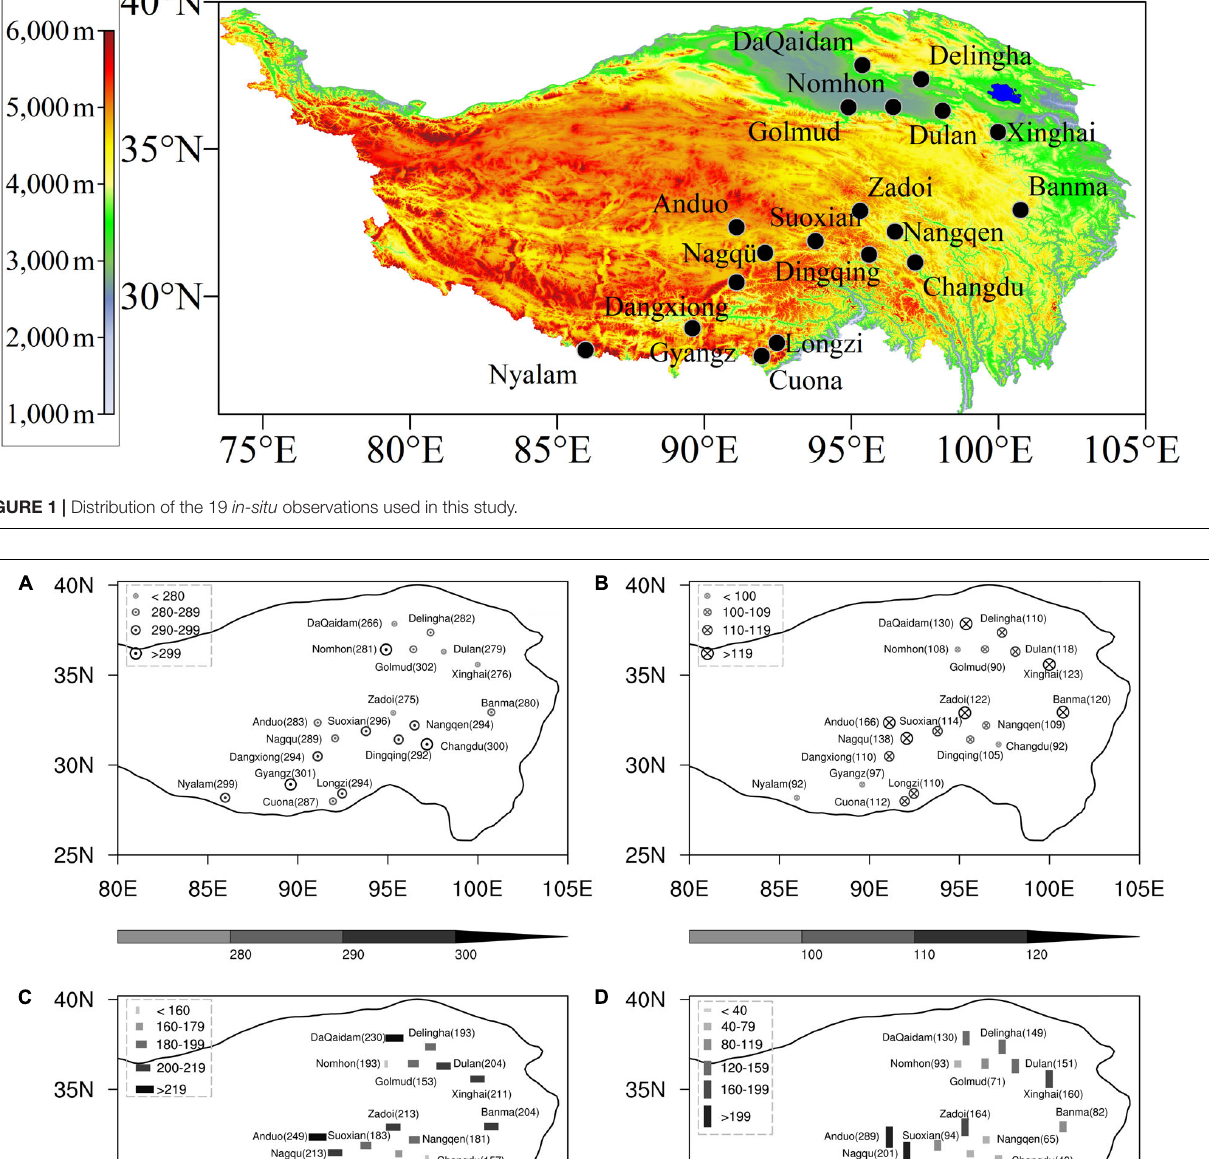
date of ground thawing was on April 14 at 2500–3000 m, and the averaged thawing date gradually delayed with the increase of altitude, the ending date of soil thawing occurred on June 1 above